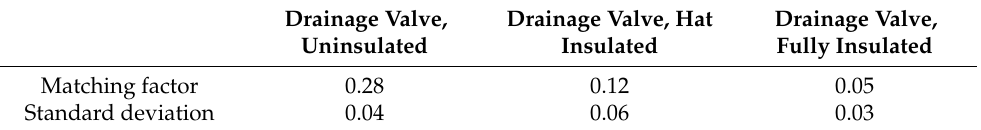
Table 3. Calculated matching factors for the drainage valves, with their standard deviations. Drainage Valve, Drainage Valve, Hat Uninsulated Insulated